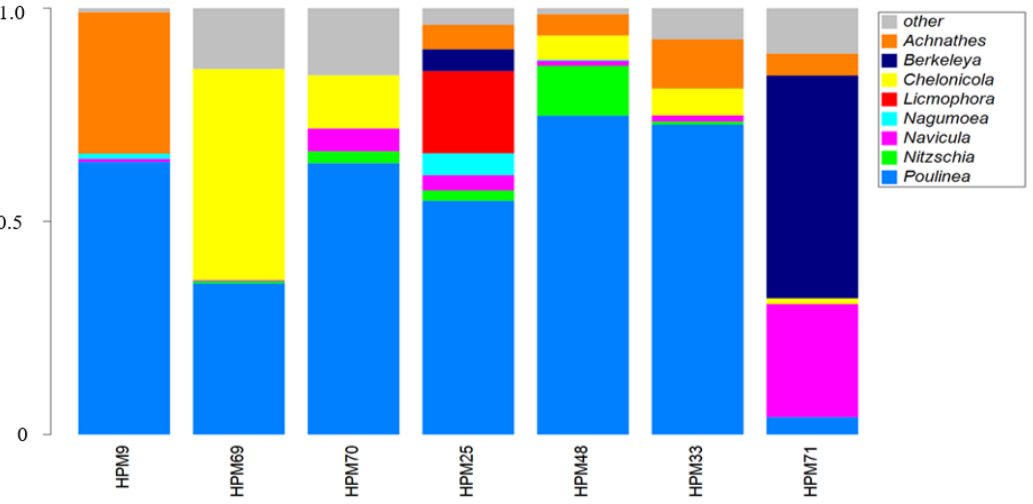
Figure 2. Relative abundance of eight most important genera found in examined skin samples of loggerhead sea turtles from the Adriatic Sea.